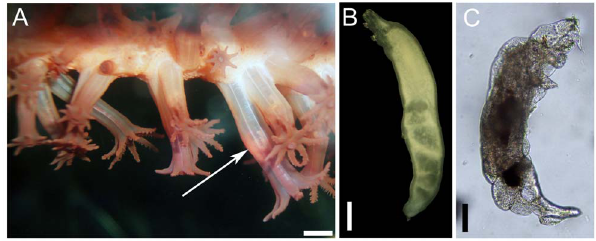
Figure 3. Lamippebouligandi , a parasitic copepod living inside the polyps of Anthoptilumgrandiflorum : (A) in situ view of the copepod (arrow) through the transparent polyp wall, (B) a female, (C) a male. Scale bar in A=1 mm, in B=500 m m and in D=100 m m.